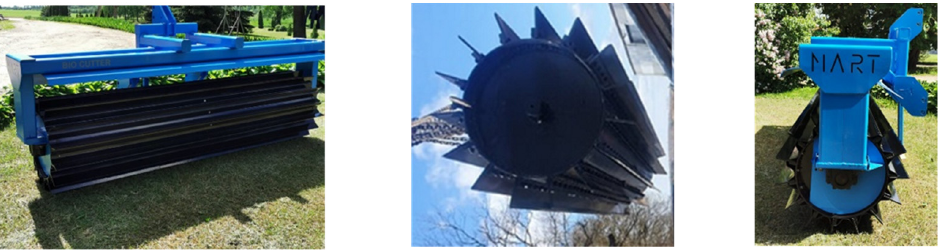
Figure 1. Cannabis residue shredding roller.